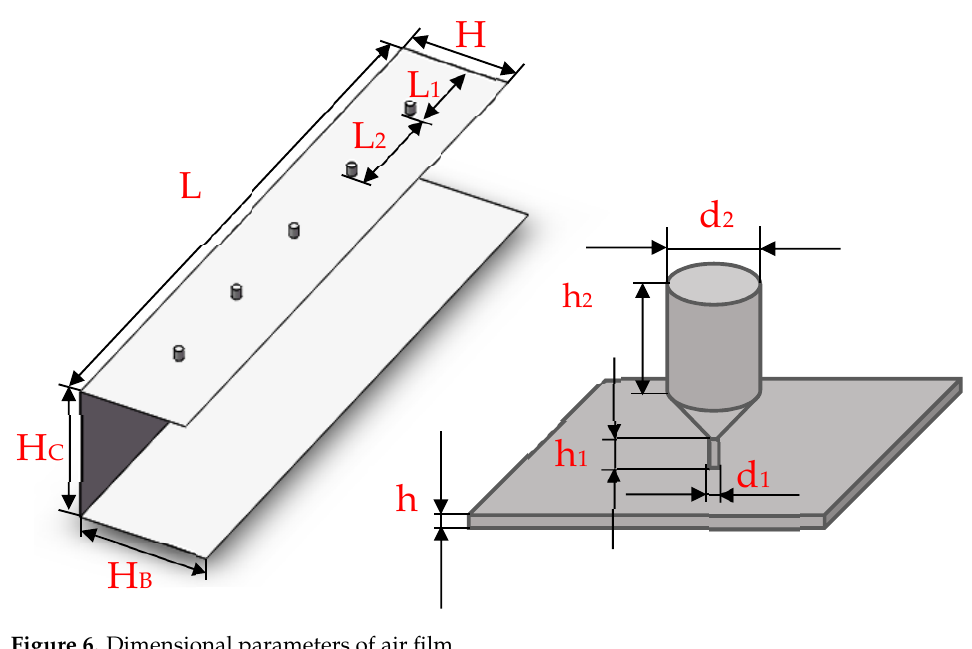
Figure 6. Dimensional parameters of air film. Table 1. Structural parameters of the model.